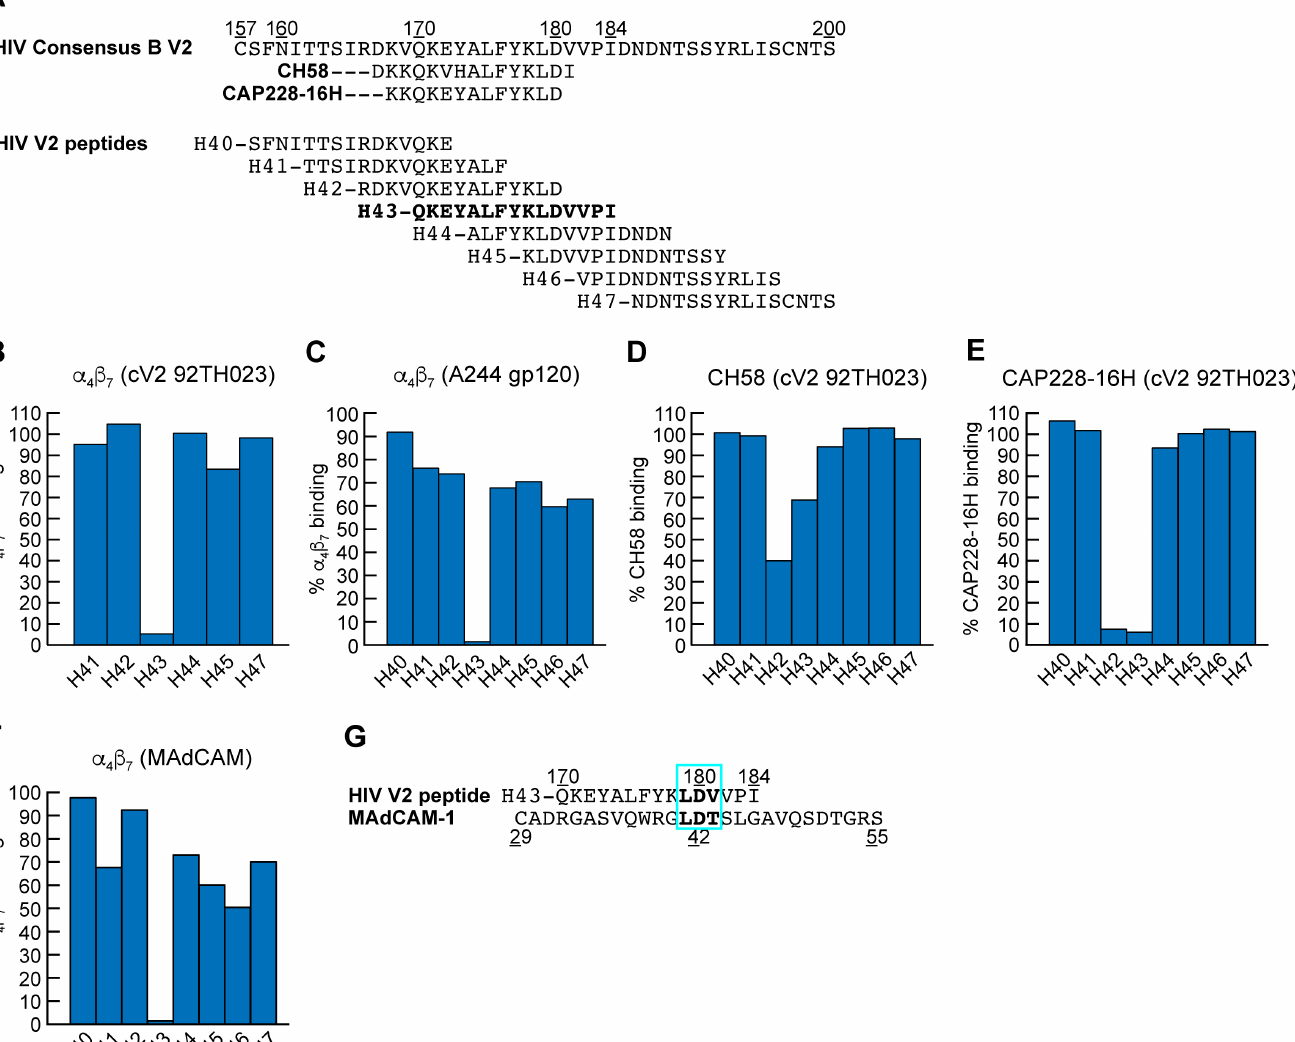
Fig 6. Inhibition of α 4 β 7 binding of HIV V2 peptides to HIV gp120, cyclic V2 and MAdCAM. A) Alignment of the V2 domains of HIV consensus B, and the eight HIV consensus B 15mer peptides (H40-H47) used in this study, and the regions of V2 recognized by mAbs CH58 and CAP228-16H. B-C) HIV 15mer peptide inhibition of α 4 β 7 binding to cV2 92TH023 and A244 gp120 as measured by SPR. Percent of α 4 β 7 binding relative to binding in the absence of peptide (defined as 100%) is shown (y-axis). D-E) HIV 15mer peptide inhibition of V2 mAbs, CH58 and CAP228-16H binding to cV2 92TH023. Percent binding relative to binding in the absence of peptide is shown (y-axis). F) HIV 15mer peptide inhibition of α 4 β 7 binding to MAdCAM. Percent α 4 β 7 binding relative to binding in the absence of peptide is shown (y-axis). Results are representative of three or more independent experiments. G) Alignment of α 4 β 7 binding site in MAdCAM IgSF domain 1, and HIV peptide H43. Conserved LDV/LDT binding motifs are boxed in blue. https://doi.org/10.1371/journal.ppat.1007278.g006 PLOS Pathogens| https://doi.org/10.1371/journal.ppat.1007278 August 28,